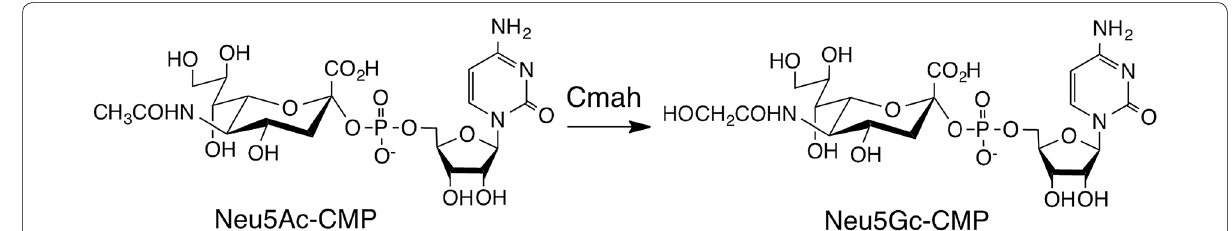
Fig. 1 The Cmah enzyme catalyzes the conversion of CMP-Neu5Ac to CMP-Neu5Gc through the addition of an oxygen